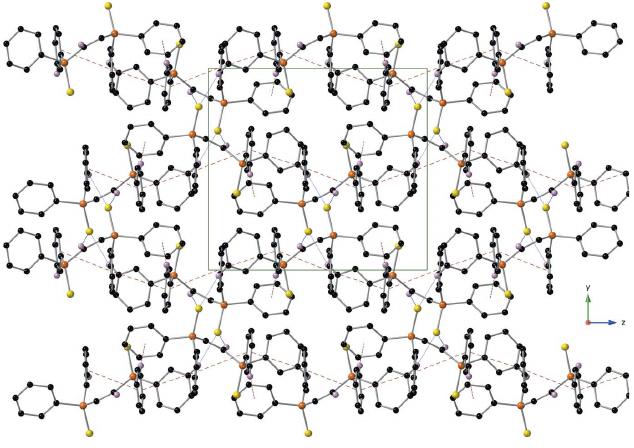
Figure 5 A packing diagram of compound I viewed down the x -axis using a ball- and-stick model with standard CPK colors. All (cid:2) – (cid:2) and C—H (cid:2)(cid:2)(cid:2) (cid:2) interactions are drawn with red dashed lines and intermolecular C— H (cid:2)(cid:2)(cid:2) S hydrogen bonds are drawn with blue dotted lines. Intramolecular C—H (cid:2)(cid:2)(cid:2) S hydrogen bonds and any hydrogen atom not involved in an interaction have been omitted for